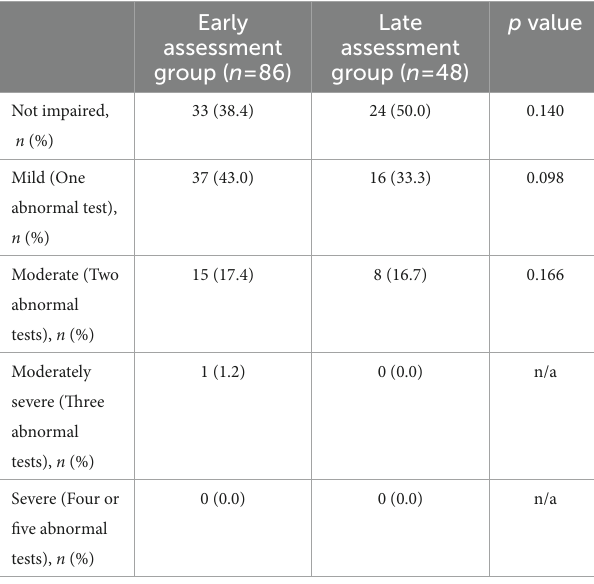
TABLE 4 The prevalence of the severity levels of cognitive impairment in the early and late assessment